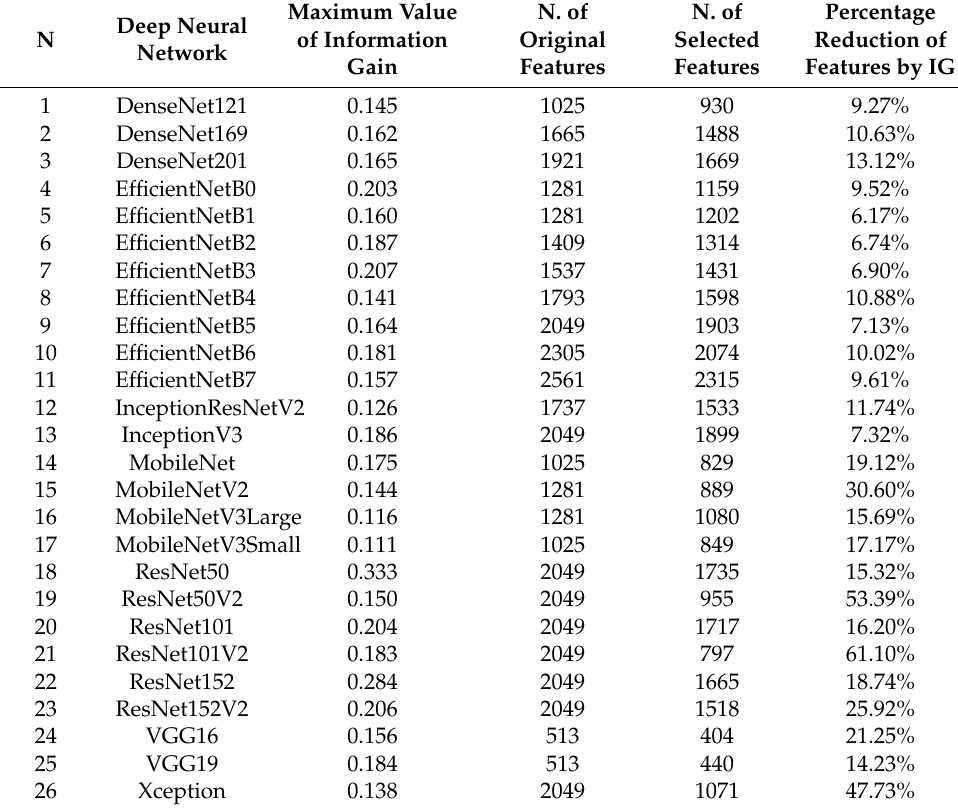
Table 2. Number of selected features by information gain for each deep neural